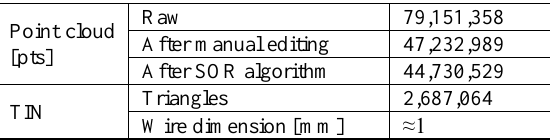
Table 4. Main characteristics of the F6 SR results